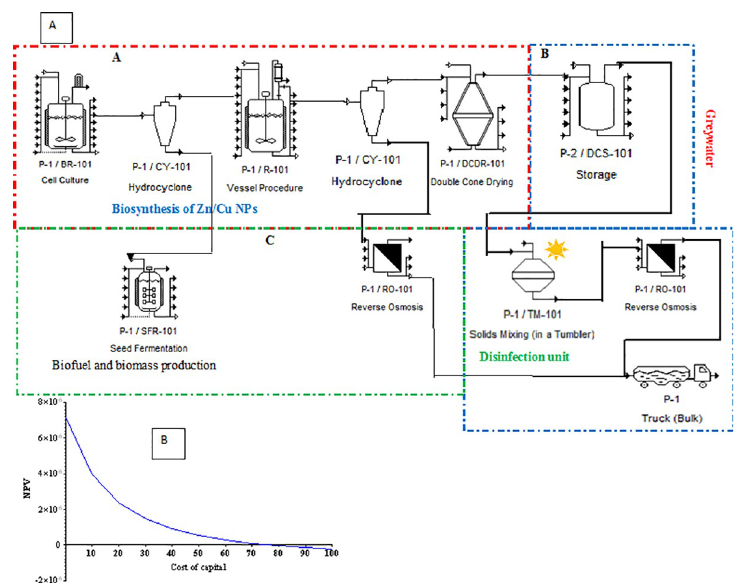
Fig 7. Zn/Cu NPs a) Flowchart of production and application; b) Internal rate of return.